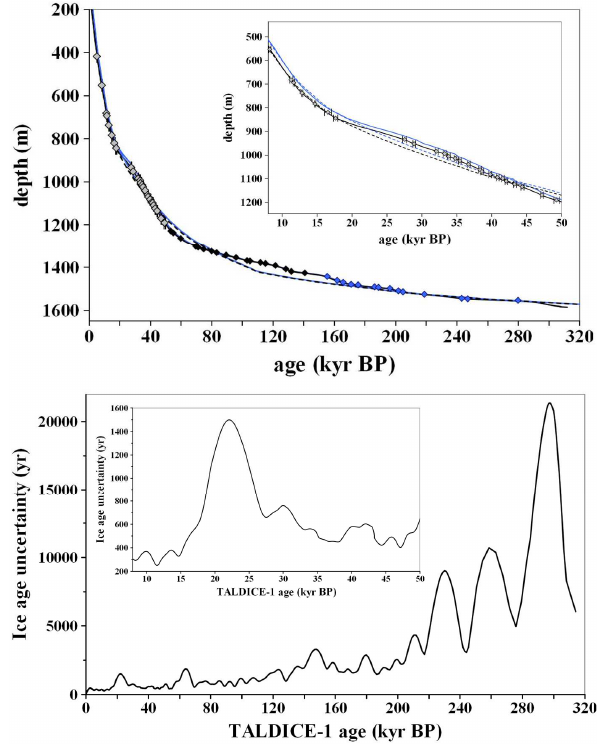
Fig. 2. Top: TALDICE-1 age/depth relationship for the ice (blue lines) and for the gas (black lines), from the a priori glaciological model (dashed lines), and after applying the inverse method (con- tinuous lines), with a zoom on the period between 8 and 50kyr BP; Bottom: uncertainty associated with the chronology deduced from the inverse method and zoomed between 8 and 50kyr